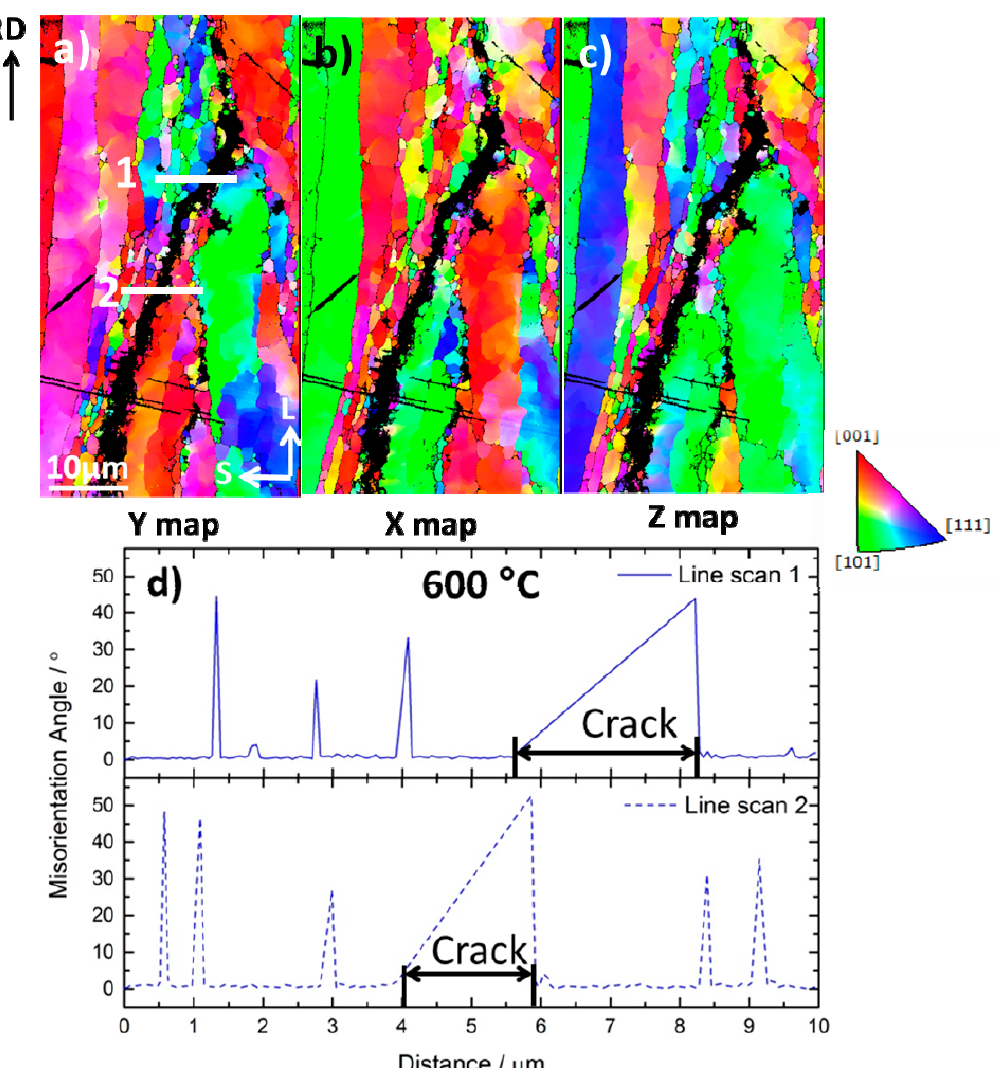
Figure 11. Misorientation line scans across a secondary crack in an L-T oriented specimen of ODS-KIT HR using EBSD IPF ( a ) X map, ( b ) Y map and ( c ) Z map of the LS plane at 600 °C. ( d ) The corresponding misorientation versus distance graph is displayed for line scans 1 and 2.